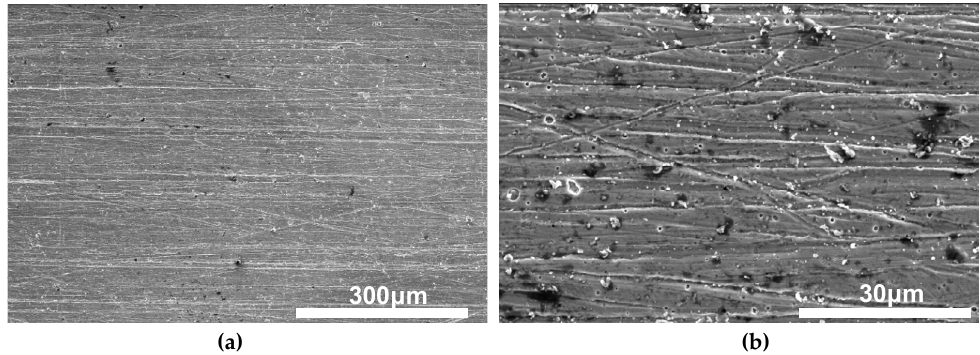
Figure 5. SEM micrographs of TiCN coating surface. ( a ) Macro morphology; ( b ) Micro morphology.